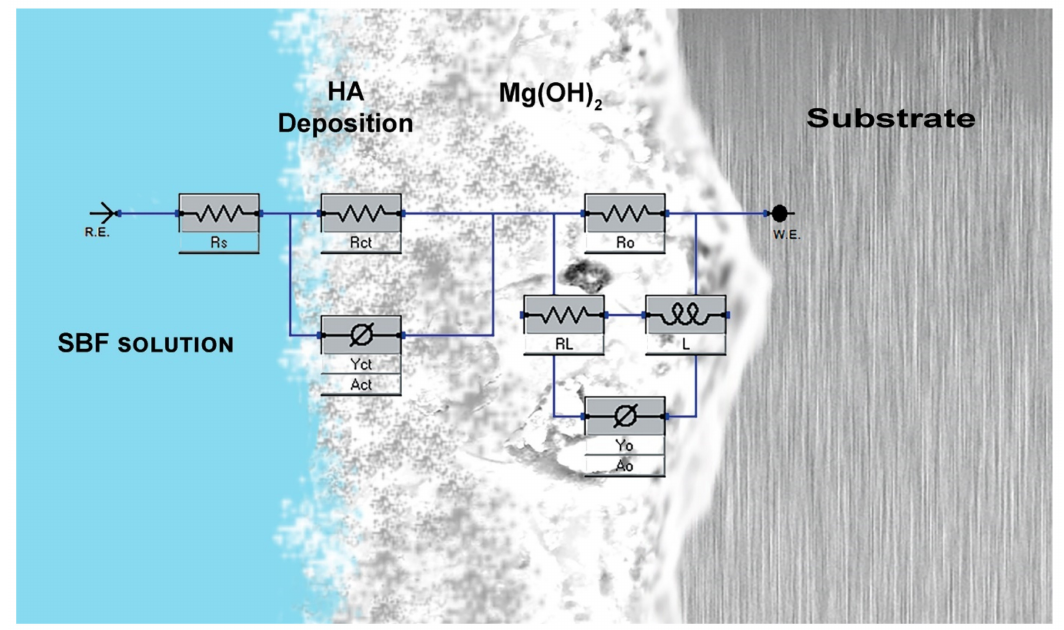
Figure 7. Equivalent circuit used for fitting the EIS curves.